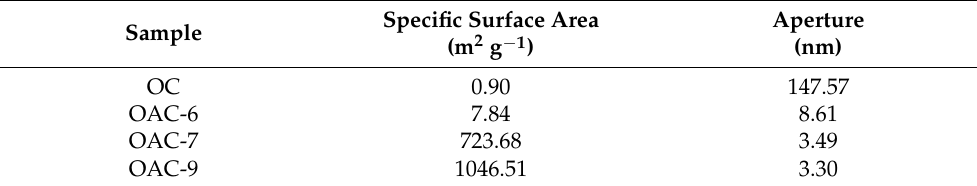
Figure 3. ( a ) N 2 sorption isotherms and ( b ) pore size distributions of OC, OAC − 6, OAC − 7, and OAC − 9. Table 1. N 2 sorption data and pore size data.